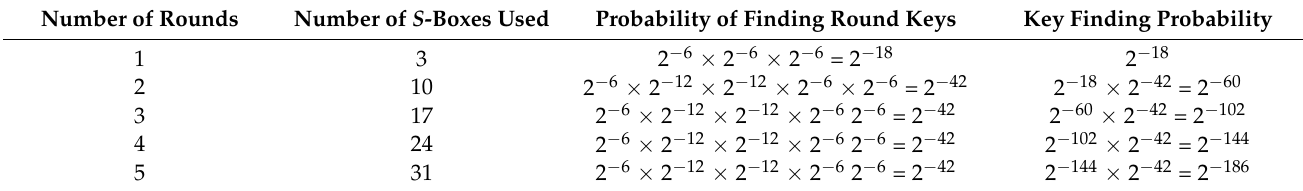
Table 10. Differential analysis of the AL02